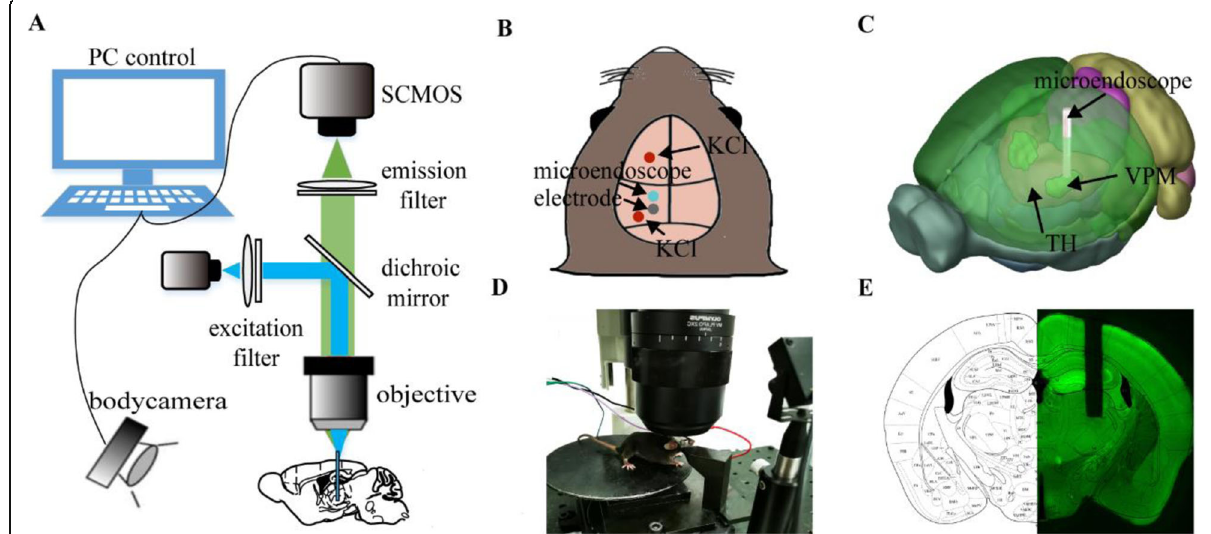
Fig. 1 Optical system for VPM fluorescence imaging in awake animals. A Schematic of the imaging system. B-C Schematic of implantation of the GRIN lens and chronic electrode. The 3D model was obtained from the Allen brain atlas. D Head-fixed setup with an infrared camera for motion detection. E Brain slices matching the standard mouse brain